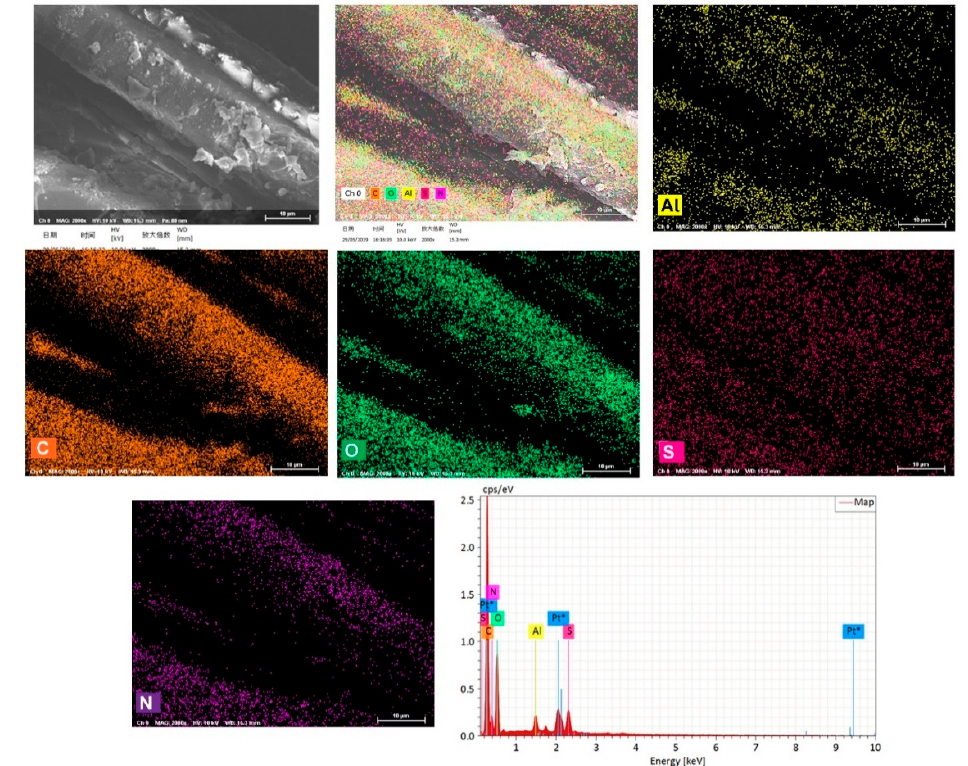
Figure 3. EDS elemental map of the surface for treated wool with alum and m-TGase .